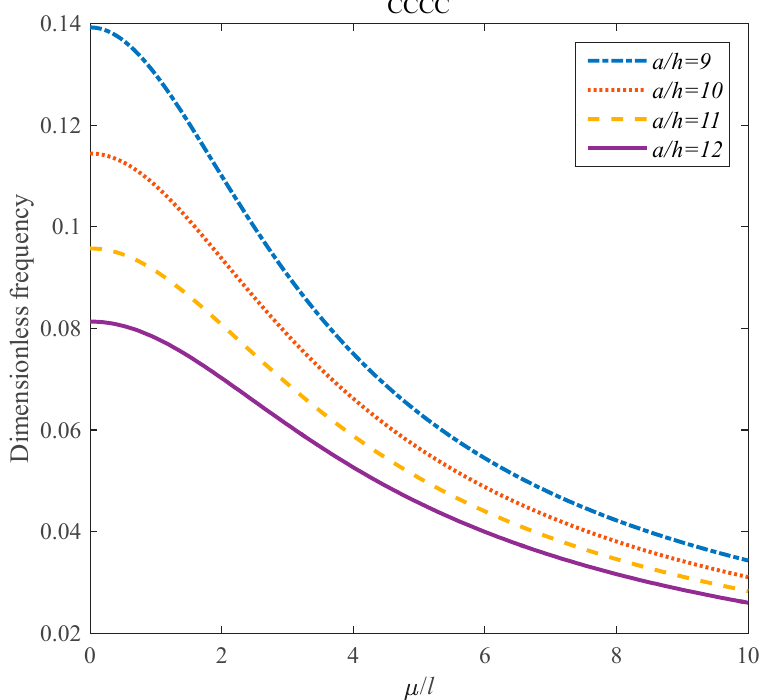
Figure 4. The influences of a / h and µ / h on the frequency for the CCCC boundary conditions with a / b = 5, l = h / 5, ∆ T = 100K, NL = 10, g_GPL = 0.5%, and GPL ‐ x.